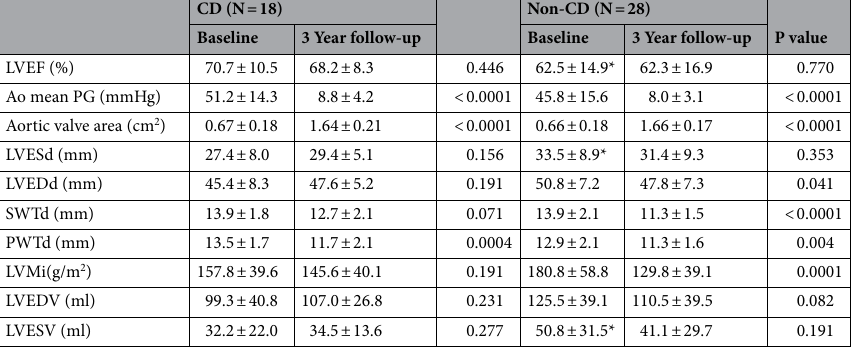
Table 4. Baseline and 3-year postprocedural echocardiographic parameters according to CD in patients complete 3-years follow-up. Mean ± SD are shown. CD conduction disturbance, LVEF left ventricular ejection fraction, LVESd left ventricular end-systolic dimension, LVEDd left ventricular end-diastolic dimension, PWTd posterior wall thickness at end diastole, SWTd septal wall thickness at end diastole, LVMi left ventricular mass index, LVEDV left ventricular end-diastolic volume, LVESV left ventricular end-systolic volume. *P < 0.05 as compared to baseline data in CD